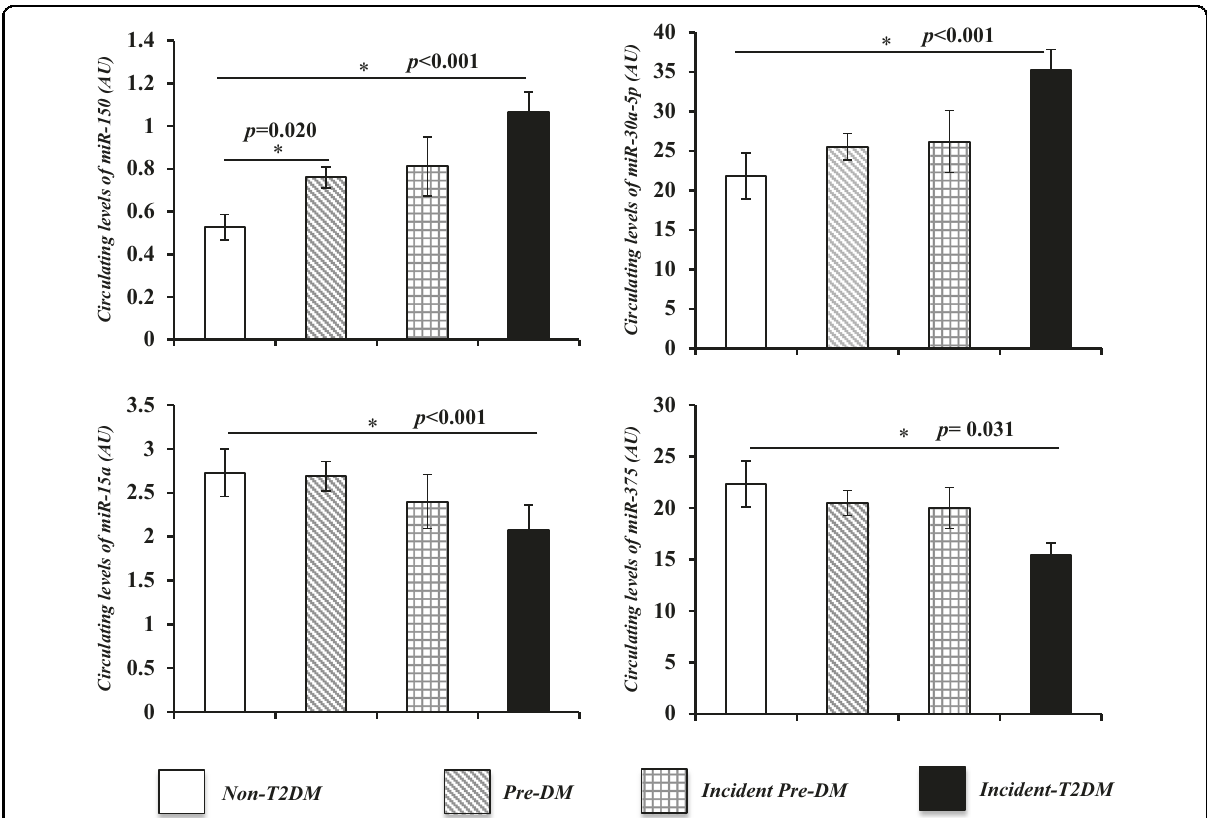
Fig. 1 Baseline levels of miRNAs studied according to pre-DM or T2DM status at a median follow-up of 60 months. Values are expressed as the mean ± standard error. Variables were calculated using ONE-WAY ANOVA through SPSS (now PASW Statistics for Windows (version 21.0) (IBM. Chicago, Illinois)). Subjects did not develop T2DM or pre-DM (non-T2DM); subjects maintained pre-DM during the follow-up period (pre-DM); subjects not pre-DM at baseline but developed pre-DM in the follow-up period (Incident pre-DM); and subjects developed T2DM (Incident-T2DM). Signi fi cance was assessed by non-parametric tests using the Mann-Whitney U test. * p <